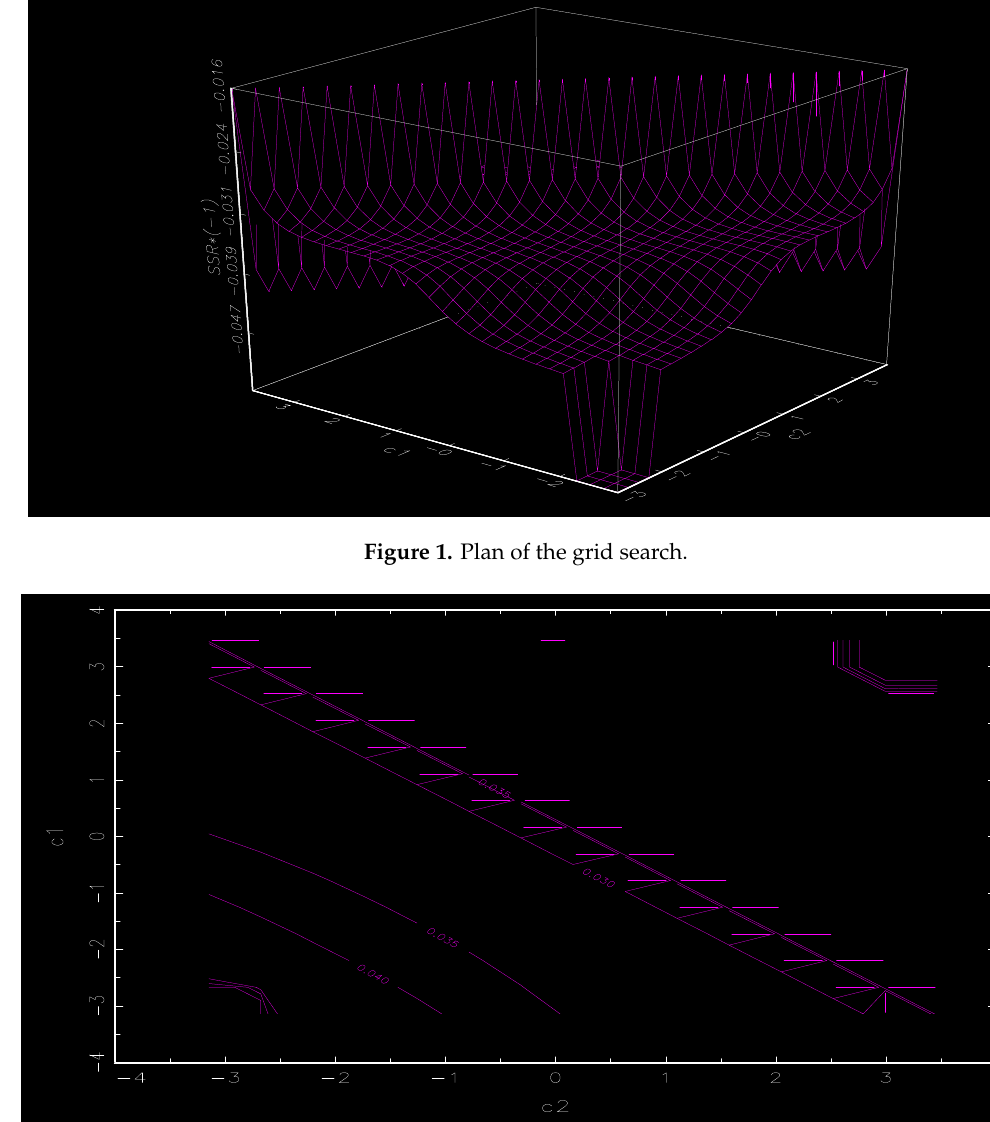
Table 5. LSTR2 model parameter estimation results. Variable